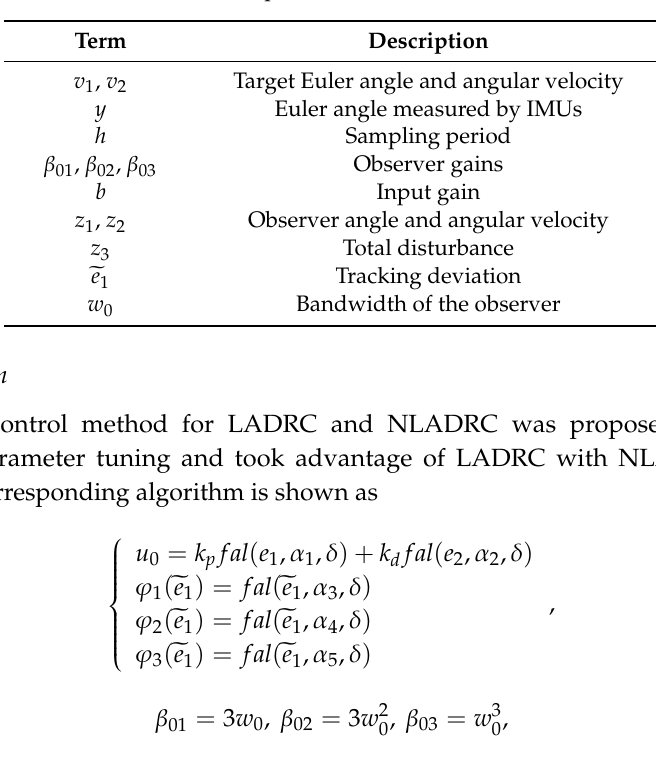
Table 1. Description of the formulaic